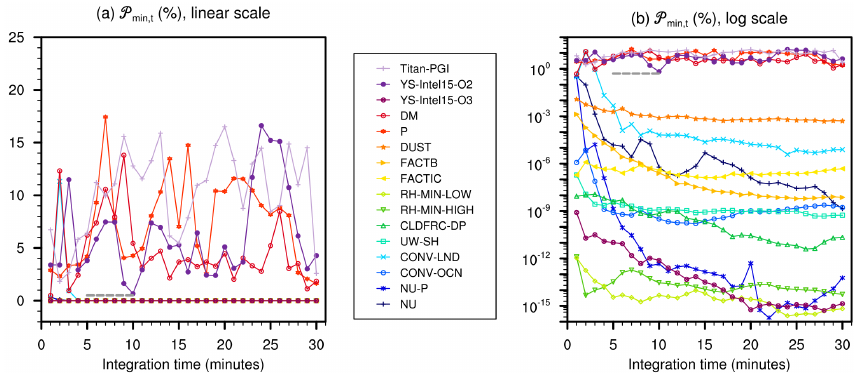
Figure 4. P min ,t as a function of model integration time, plotted in linear scale (a) and in logarithmic scale (b) . The dashed gray lines indicate the threshold for assigning an overall “pass” or “fail” to a test ensemble (see Eq. 8 and the text above